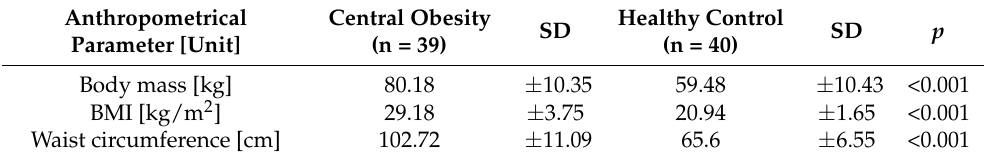
Table 2. Comparison of the anthropometrical characteristics of the central obese and control group.